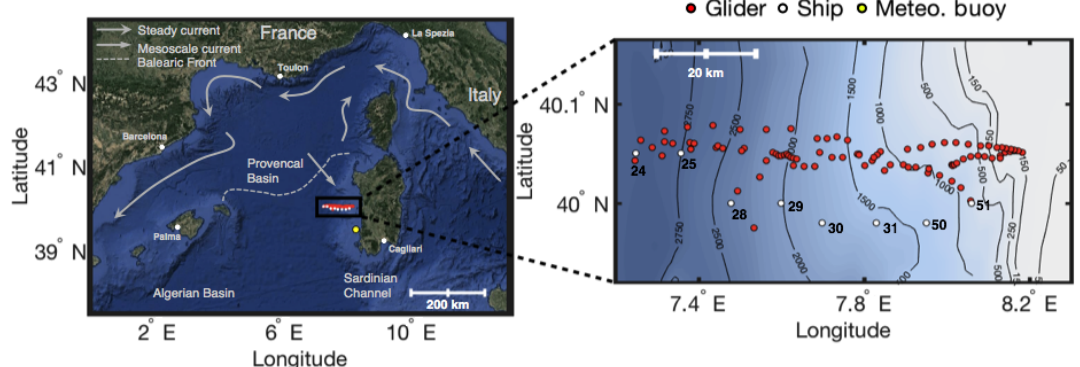
Figure 1. The locations of the 93 dives undertaken by the Seaglider (red markers), the eight ship CTD casts in which water samples were obtained (white markers), and meteorological buoy M1 (yellow marker) within the REP14-MED observational domain off the coast of Sardinia, Italy between 11 and 23 June 2014. GEBCO 1min resolution bathymetry data (metres) were used (http://www.bodc.ac.uk/projects/ international/gebco/), and surface circulation patterns were adapted from figures presented by Millot